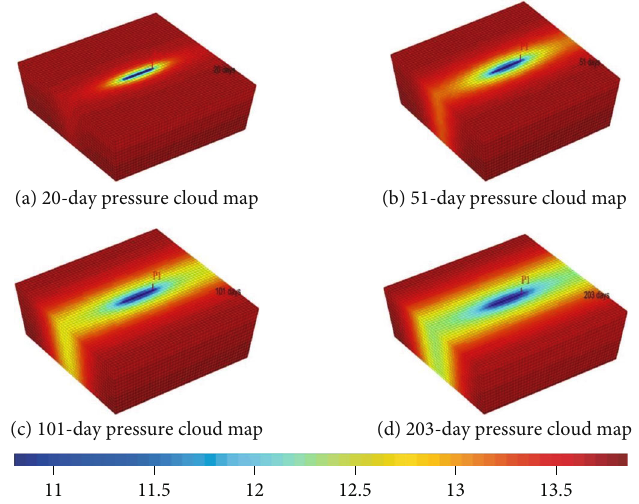
Figure 5: Pressure cloud diagram of horizontal well in anisotropic reservoir at di ff erent production times.